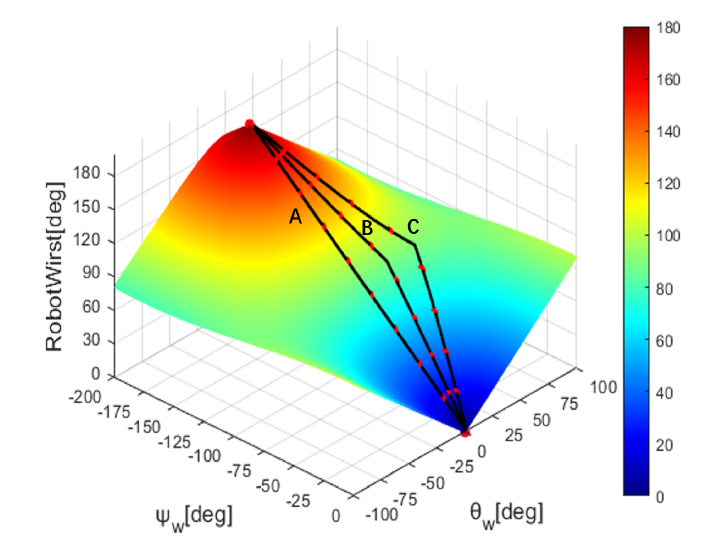
Figure 10. Schematic diagram of three human trajectories mapped to the same robot